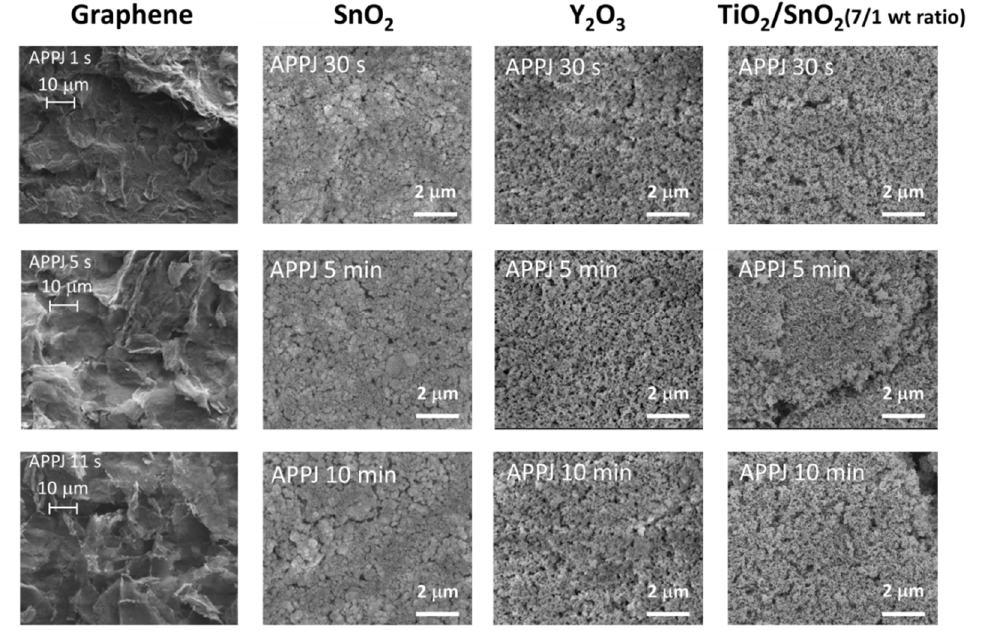
Figure 4. SEM images of rGOs [27], nanoporous SnO 2 , Y 2 O 3 , and TiO 2 /SnO 2 sintered by APPJs for various